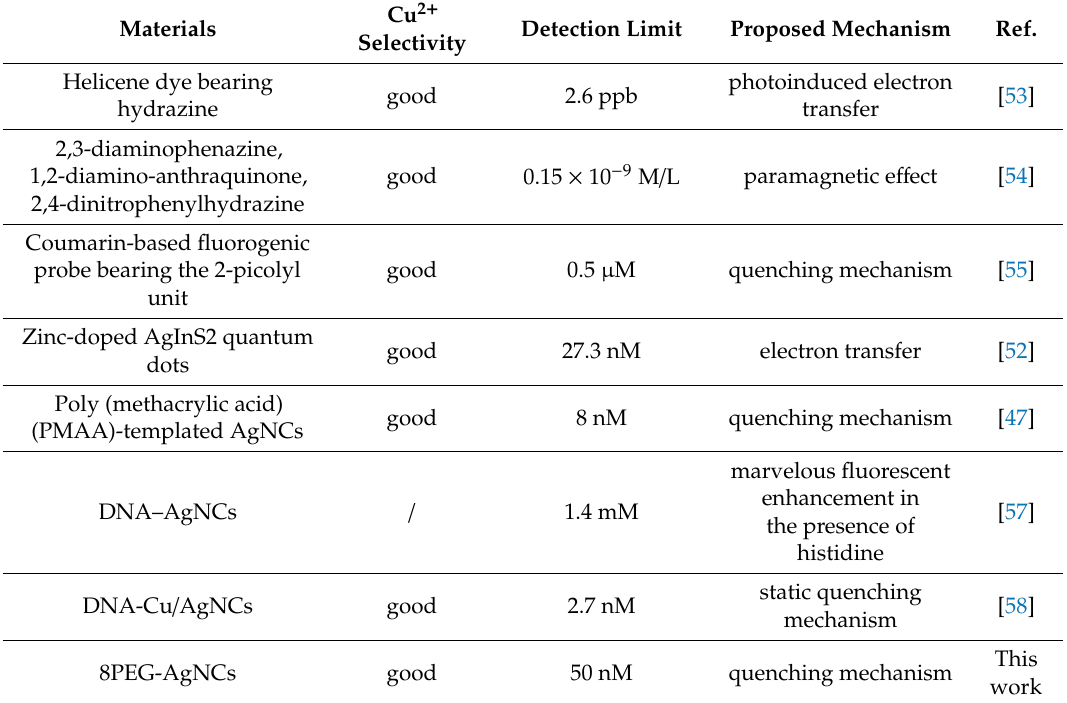
Table 1. Some examples of sensors for Cu 2 + ion